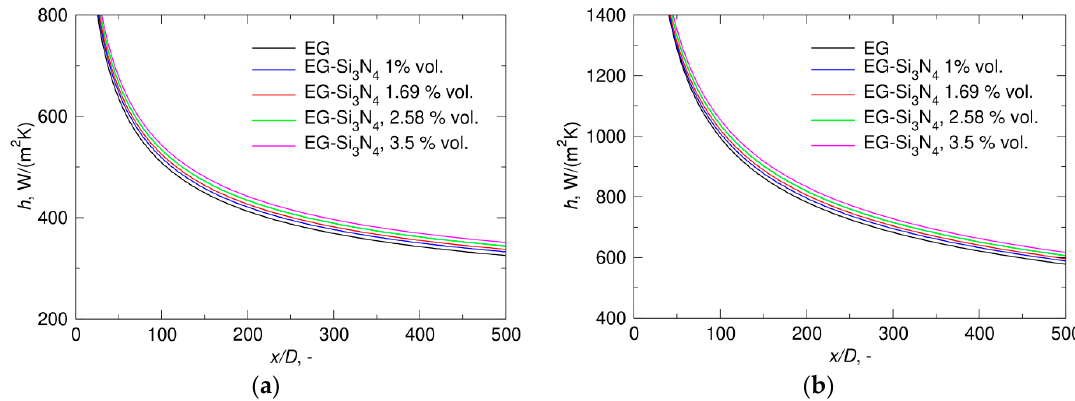
Figure 8. Computational results for laminar flow of EG-Si 3 N 4 nanofluid with various nanoparticle volume fractions and the imposed wall heat flux q = 10 kW/m 2 : ( a ) Heat transfer coefficient at the volume flow rate of Q = 8 × 10 − 6 m 3 /s, which corresponds to Re = 200 for pure EG; ( b ) Heat transfer coefficient at a volume flow rate of Q = 6 × 10 − 5 m 3 /s, which corresponds to Re = 1500 for pure EG.